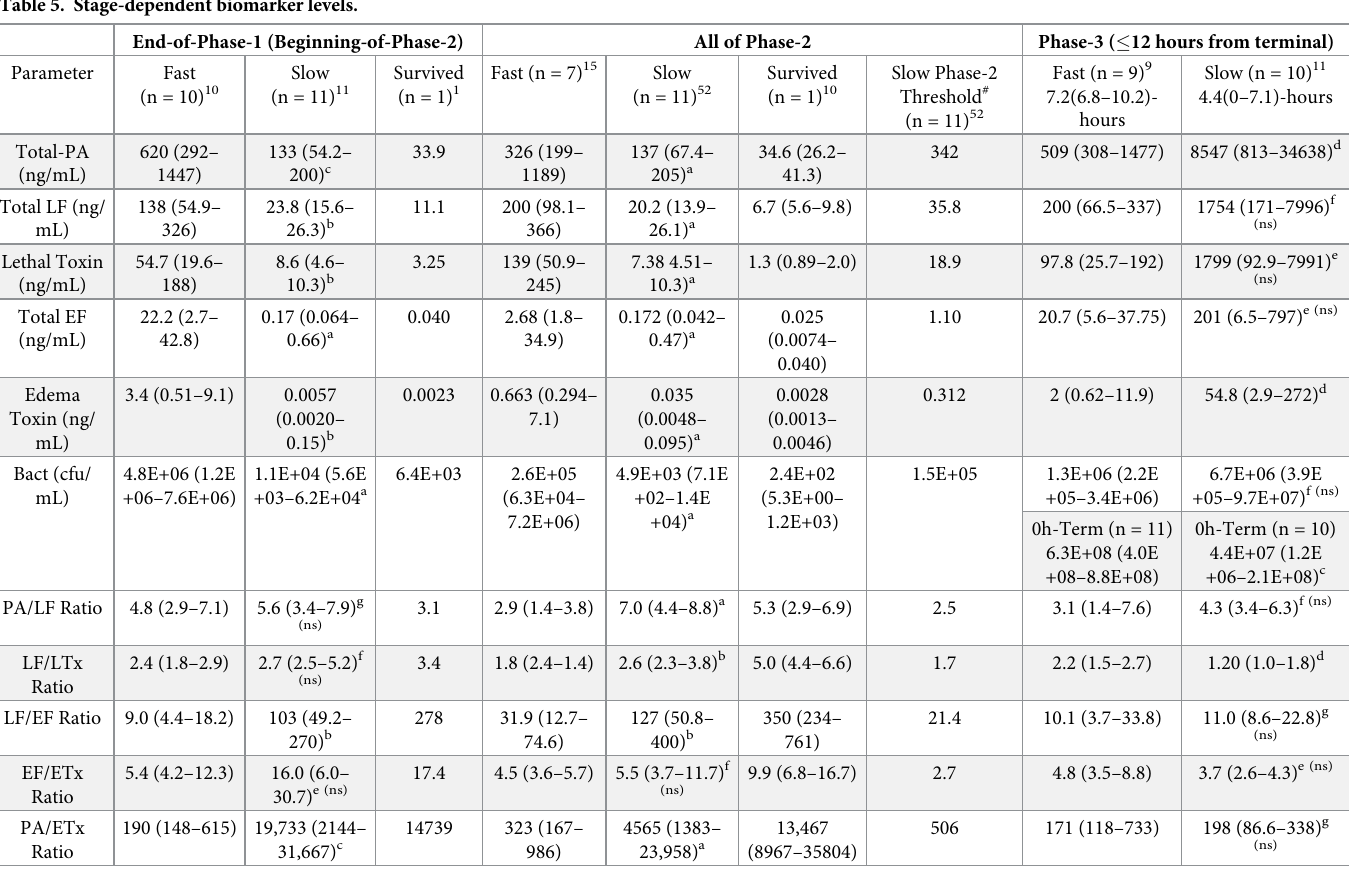
Table 5. Stage-dependent biomarker